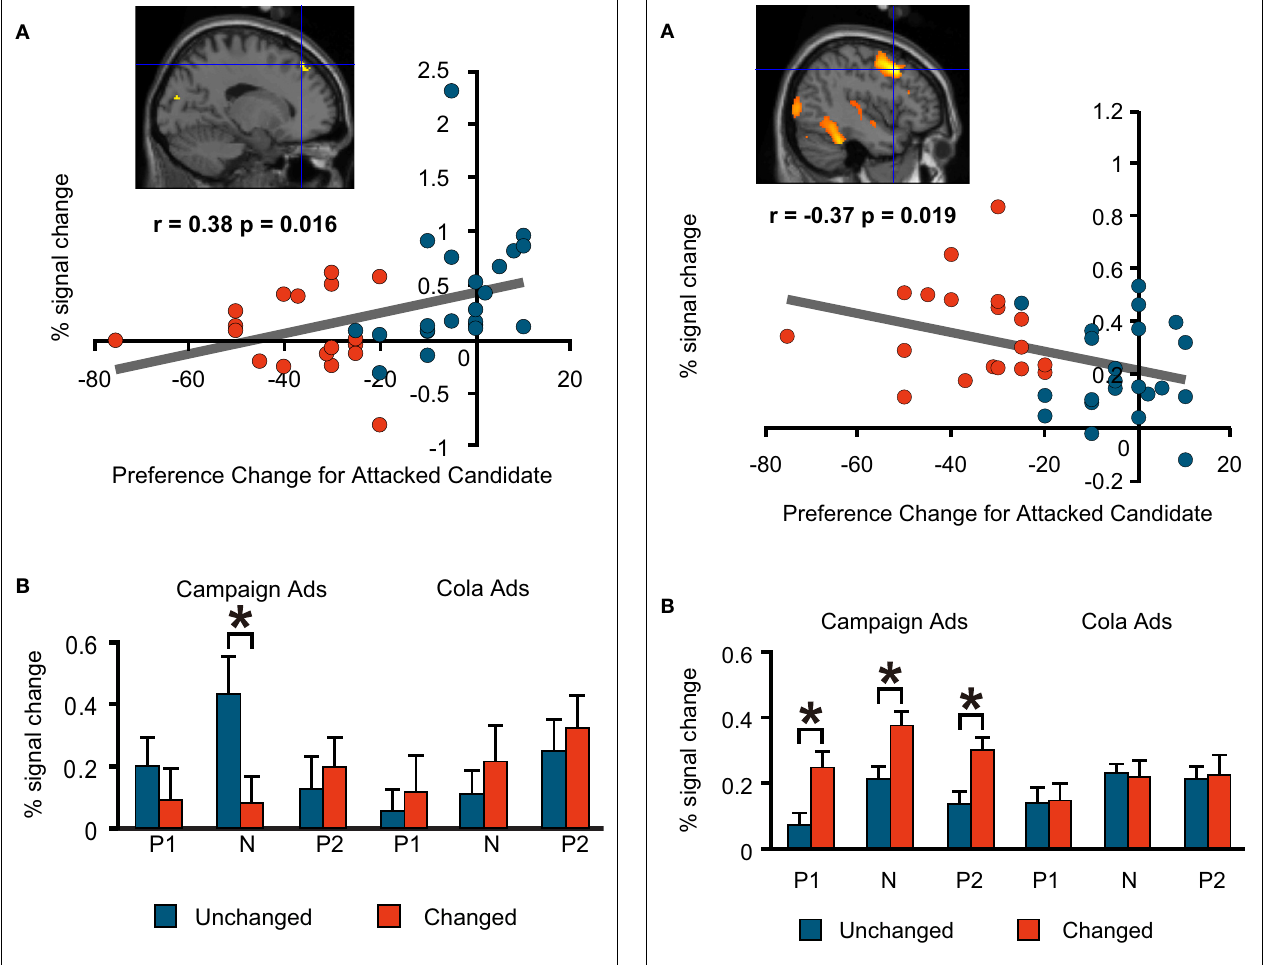
FIGURE 4 | fMRI signal change at the medial prefrontal cortex ( − 16, 39, 44; BA8). (A) Correlation between the signal change during the negative advertisements and preference change towards a favoured candidate during the negative advertisements (=post-negative-advertisement preference for the attacked candidate − pre-negative-advertisement preference for the attacked candidate). Blue, Unchanged; red, Changed. Note that each plot represents an individual subject. (B) Mean comparison between the Unchanged and Changed Groups for each advertisement session. P1, Positive1; N, Negative; P2, Positive2. The asterisk indicates a signifi cant difference at p < 0.05 ( t -test). The error bars are the S.E.M.)